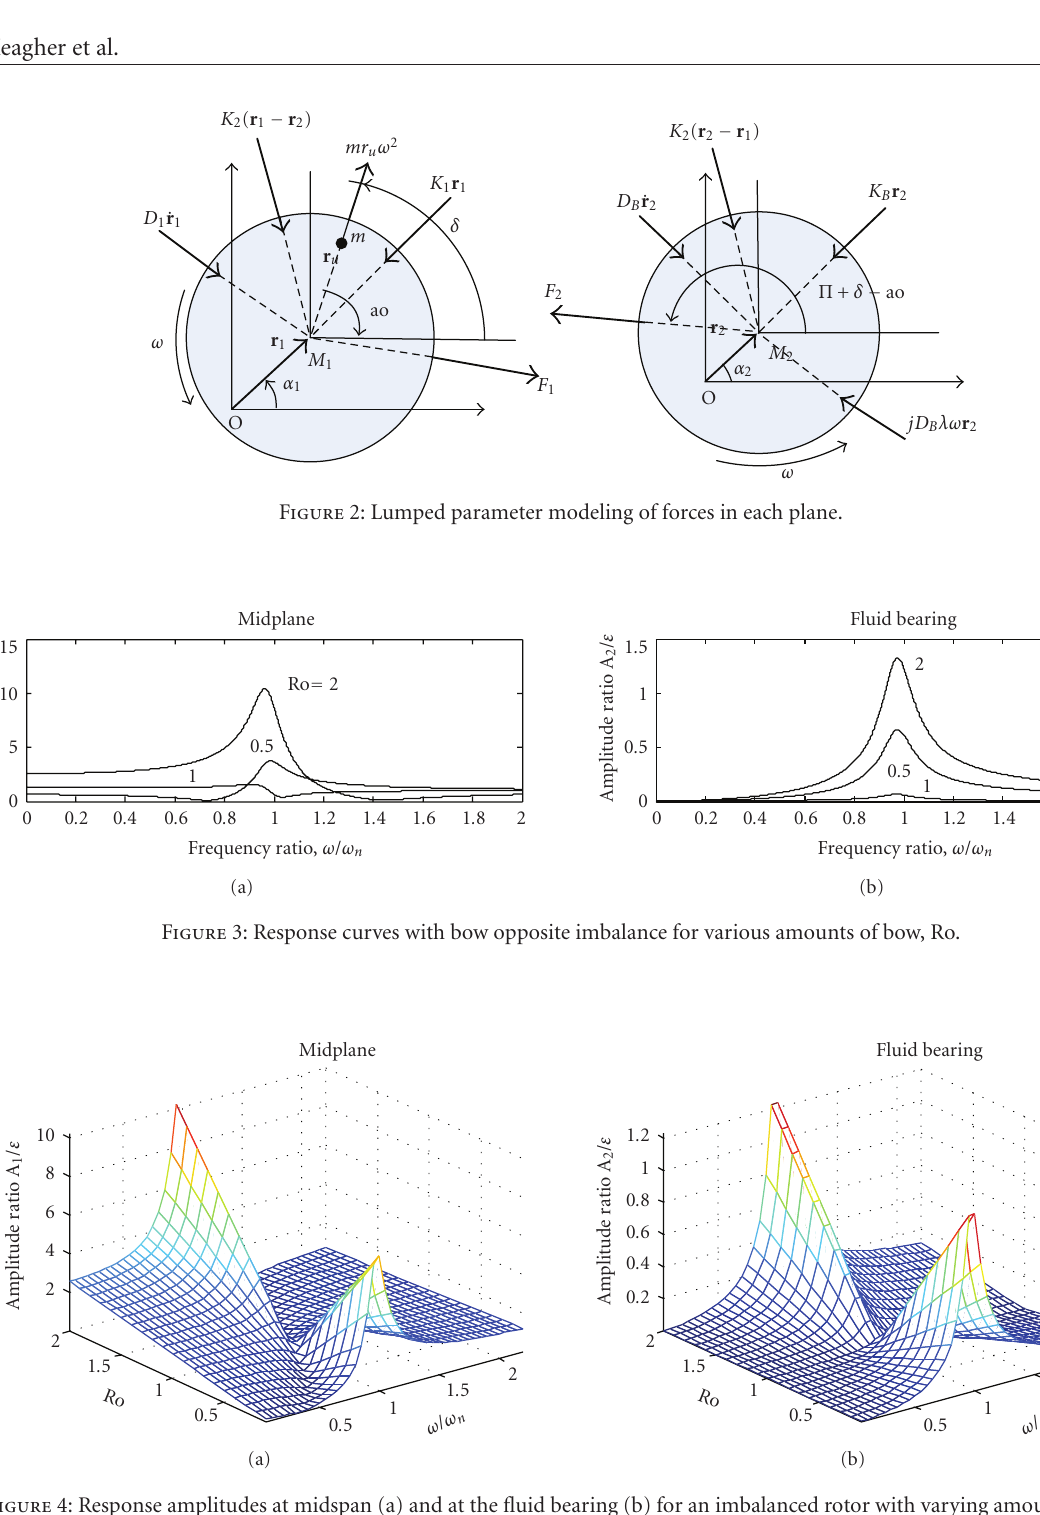
Figure 4: Response amplitudes at midspan (a) and at the fluid bearing (b) for an imbalanced rotor with varying amount of